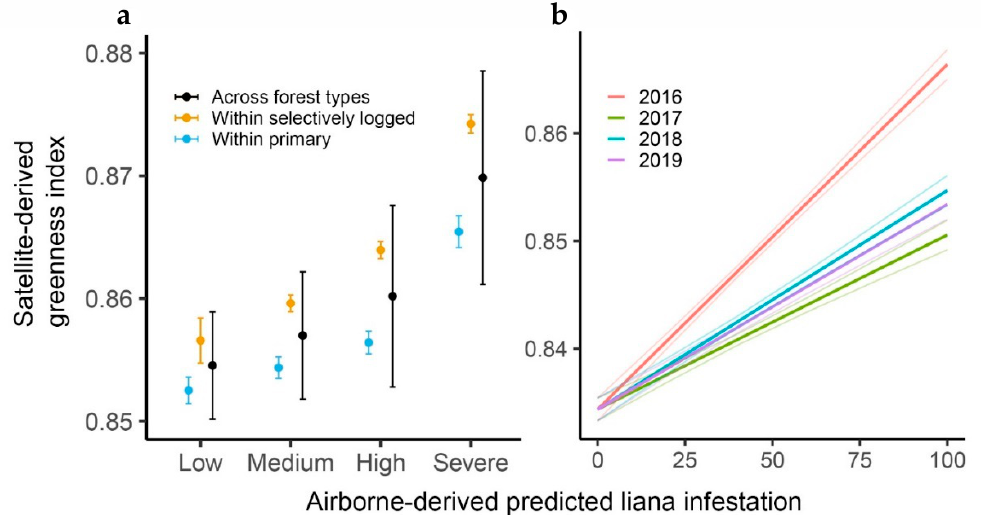
Figure 2. Satellite-derived predicted mean greenness ( a ) combined for all years (2016–2019) across forest types (black) and within the primary (blue) and selectively logged (orange) forests in response to airborne-derived liana infestation classes and ( b ) for each year in response to airborne-derived liana infestation percent cover. Liana infestation classes are defined as: Low [<25%], Medium [26–50%], High [51–74%] and Severe [>75%]. Error bars are 95% confidence intervals based on error in model fit as well as uncertainty derived from error in airborne-derived liana infestation estimates. Table 1. Pairwise comparison of linear regression slope coefficients (in Figure 2b). P-values ad- justed using Bonferroni correction. Significance level set at 0.05. Contrast (Years)